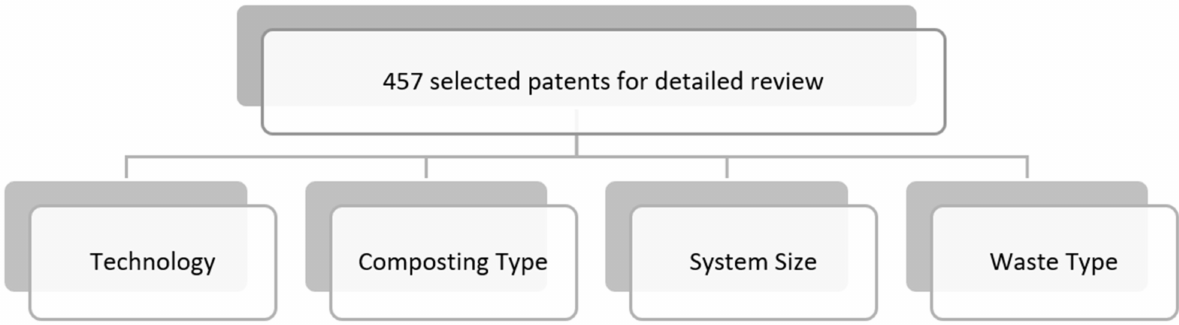
Figure 7. Categorization type of the selected